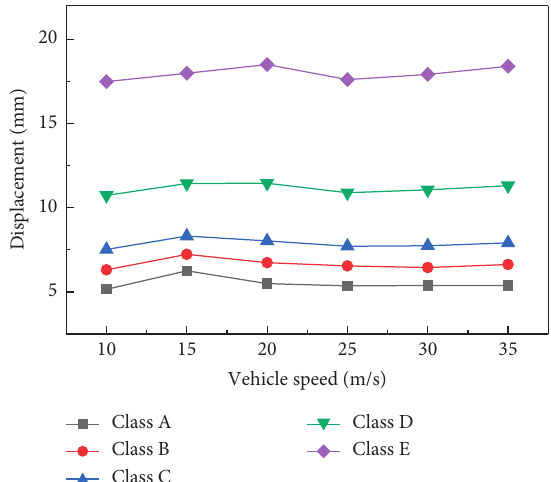
Figure 8: Maximum response of bridge displacement via various vehicle and roughness